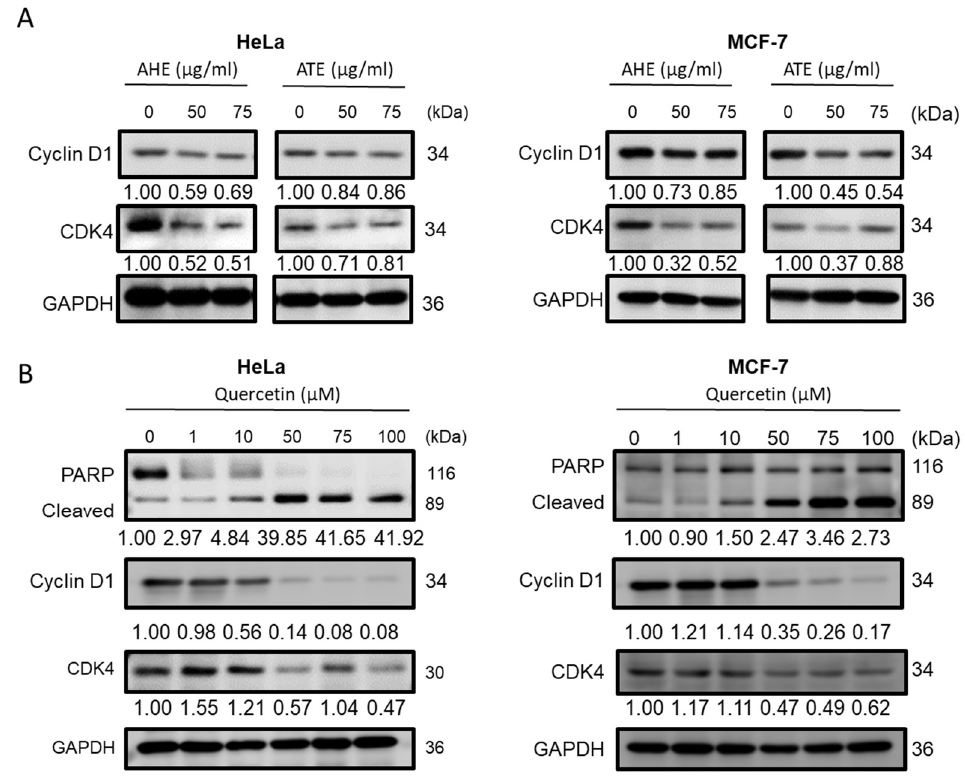
Figure 4. The effects of adlay extracts or the active component quercetin on cell cycle arrest and apoptosis-related protein expression in HeLa and MCF-7 cells. The HeLa or MCF-7 cells were cultured in DMEM and MEM media containing ( A ) AHE or ATE or ( B ) quercetin for 48 h. Then, a western blot was used for the protein expression analysis.